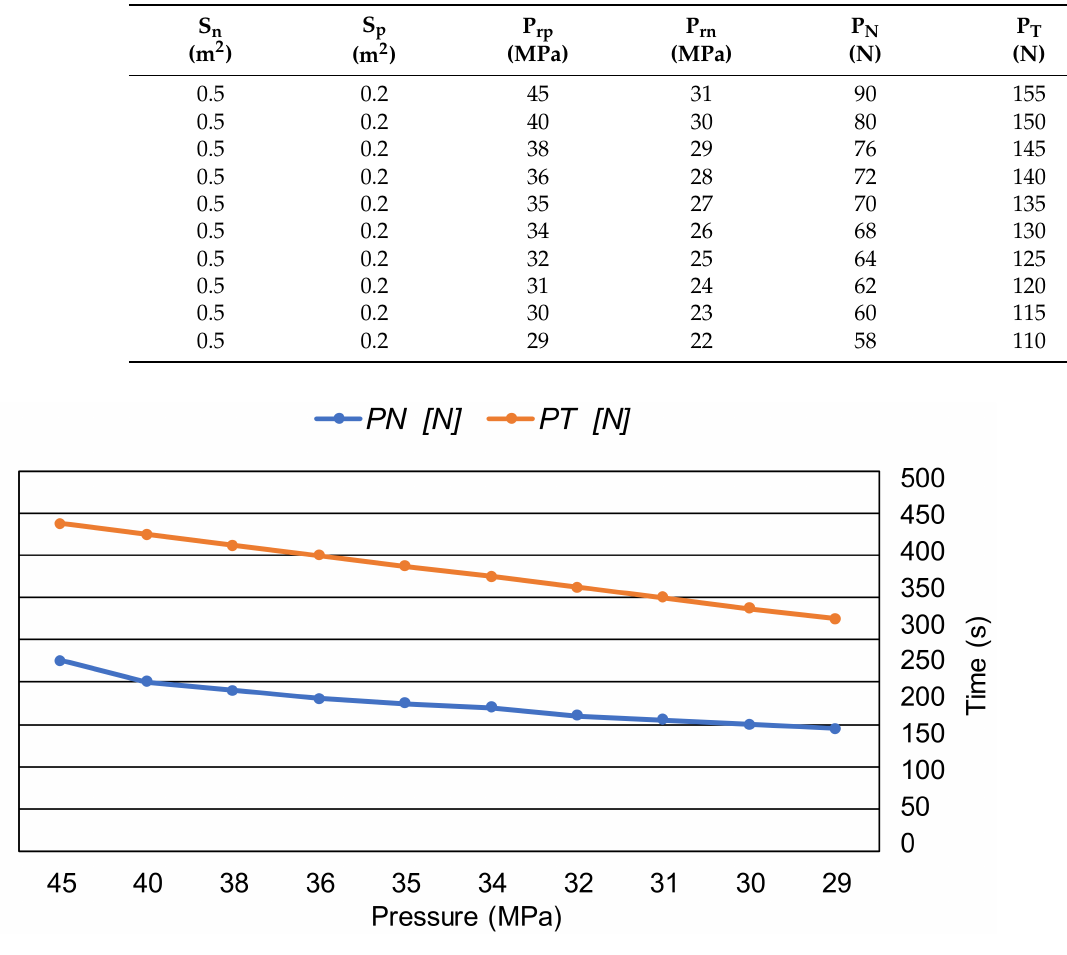
Figure 10. Comparison between the over-lock operation of the floor-support actuator and the under- lock